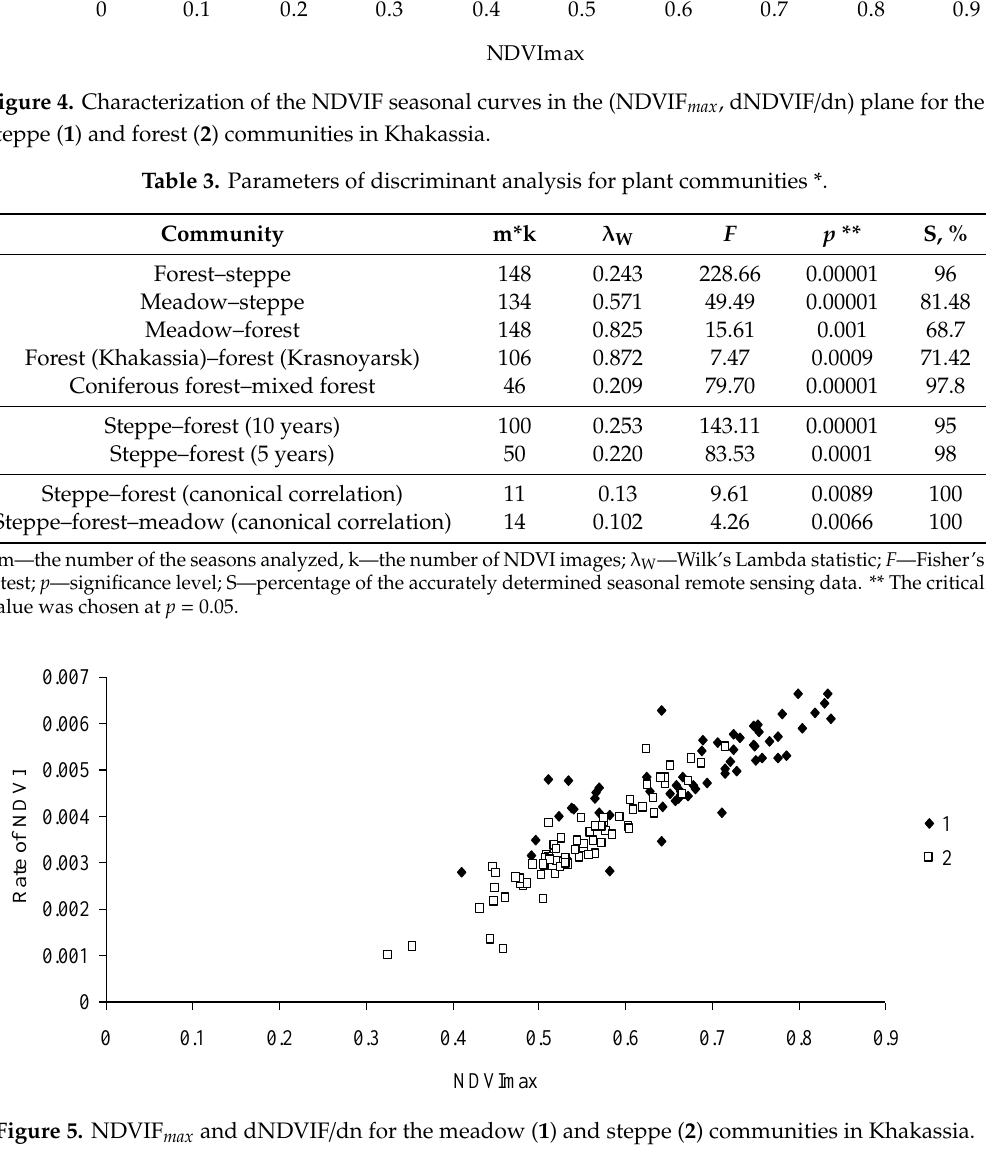
Table 3. Parameters of discriminant analysis for plant communities*